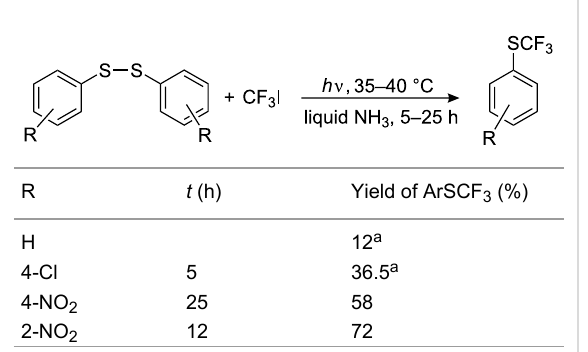
a Extracted from